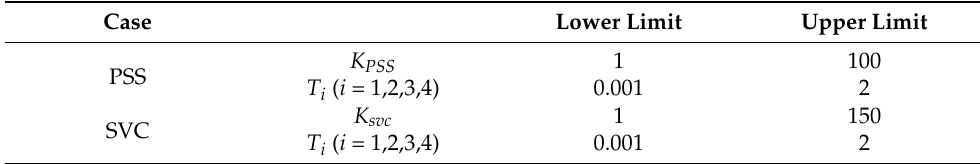
Table 3. Upper and lower limits of PSSs and SVC parameters.